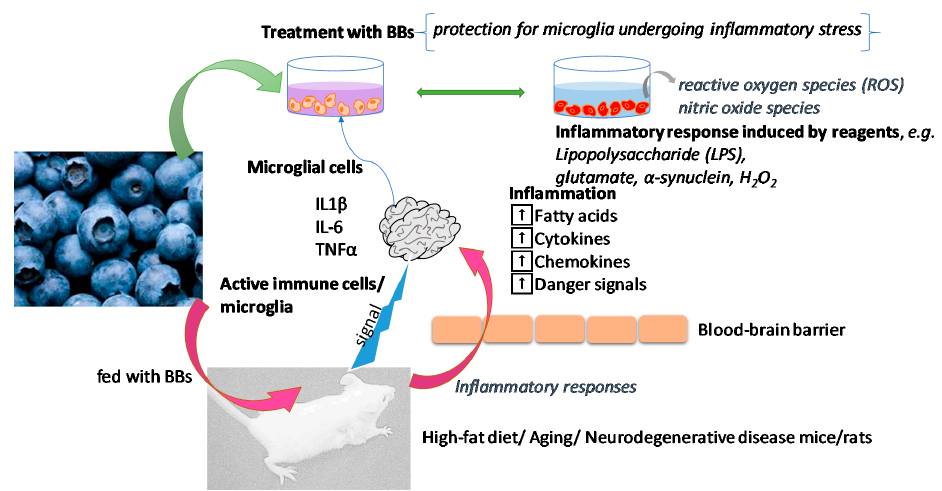
Figure 1. Effects of blueberry (BB) supplementation on brain dysfunction in in vitro and animal models. BBs can reduce the activation of microglial cells and decrease the release of ROS and/or nitric oxide species produced by inflammatory responses induced by reagents in in vitro studies. Meanwhile, BBs also demonstrate their neuroprotective effects in high- fat diet/ageing/neurodegenerative disease animal models against inflammatory responses regulated by peripheral pro- inflammatory molecules (fatty acids, cytokines, chemokines, danger signals), which can signal the immune cells of the brain (mainly represented by microglia) to release pro-inflammatory molecules such as interleukin-1beta (IL1 β ), IL-6, and tumor necrosis factor alpha (TNF α ).